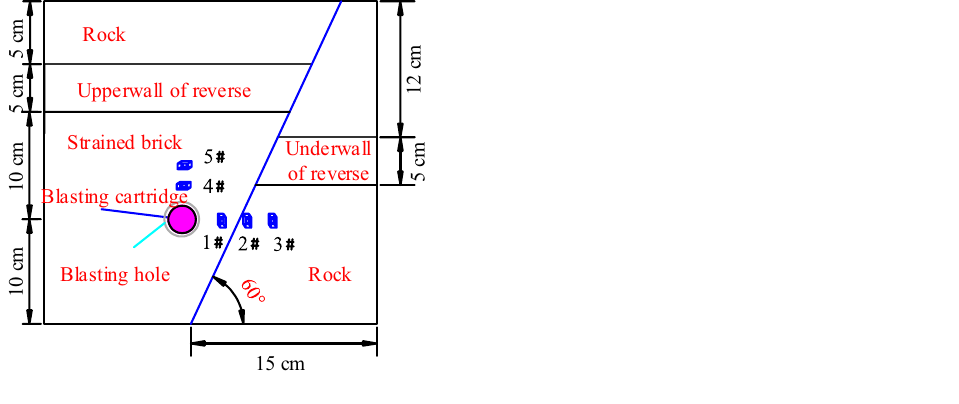
Figure 9. Stress measuring point.